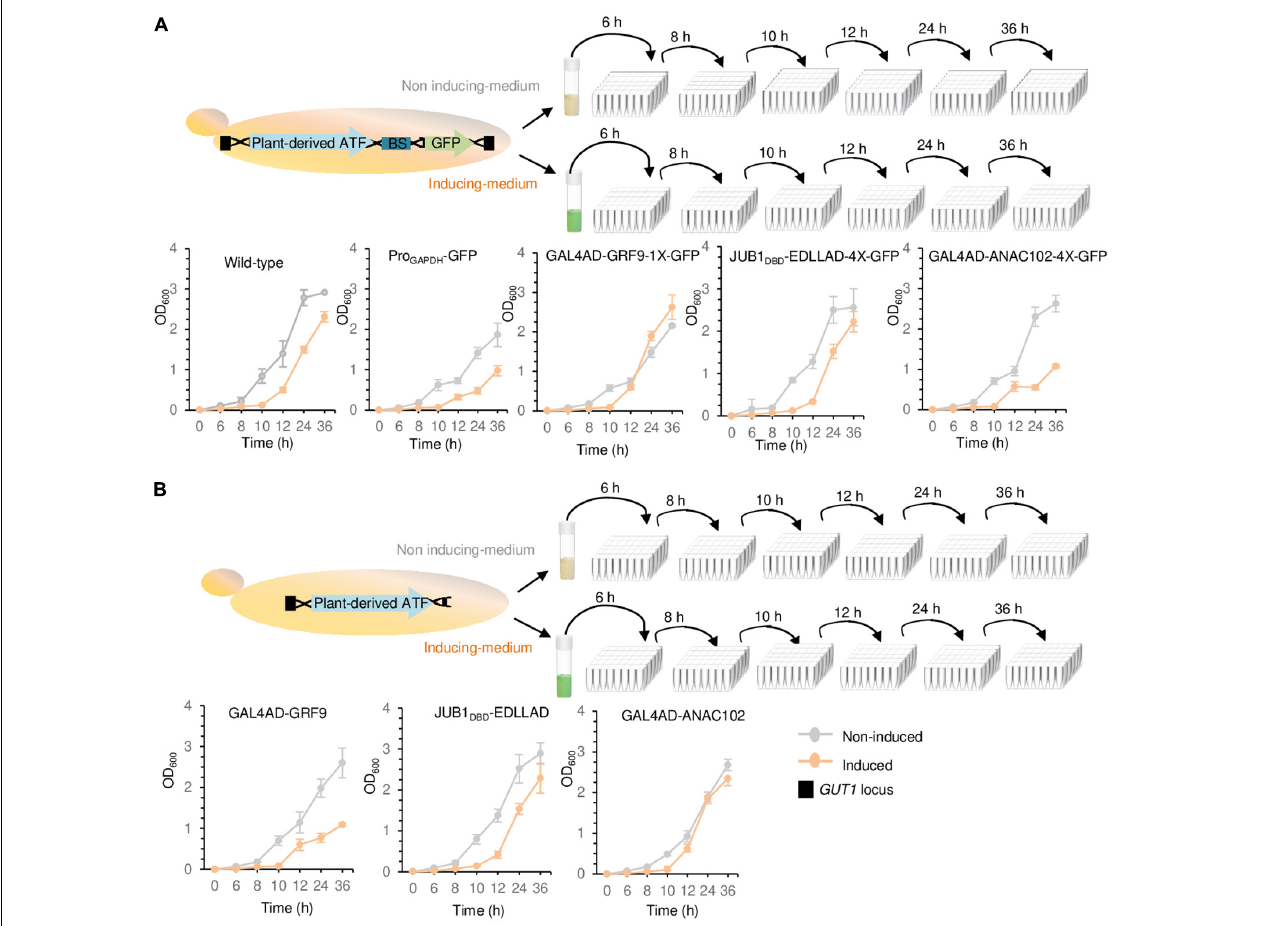
FIGURE 4 | Growth assays. (A) Growth assay of yeast cells containing chromosomally integrated driver and reporter modules. (B) Growth assay of yeast cells containing chromosomally integrated driver modules. The strains containing either the integrated driver/reporter or driver modules were inoculated in induction (orange line) and non-induction (gray line) medium, followed by OD 600 measurement at 0, 6, 8, 10, 12, 24, and 36 h. Wild-type JC308 was used as a control. “1X” and “4X” indicate one or four copies of the TF binding site, respectively. To simplify the figure, the modified GAL1 promoter and CYC1 terminator located upstream and downstream of plant-derived ATFs, NLS, and the minimal CYC1 promoter located upstream of GFP are not shown. EDLLAD, activation domain from plant; GAL4AD, GAL4 activation domain of yeast; GRF9, Growth-Regulating Factor 9; JUB1, NAC TF JUNGBRUNNEN1; ANAC102, A NAC TF 102; DBD, DNA binding site; Pro, promoter. Data are expressed as the mean OD 600 values ± SD obtained from three cultures, each derived from an independent yeast colony and determined in three technical replicates. OD 600 , optical density at 600 nm. The full data are shown in Supplementary Data 3